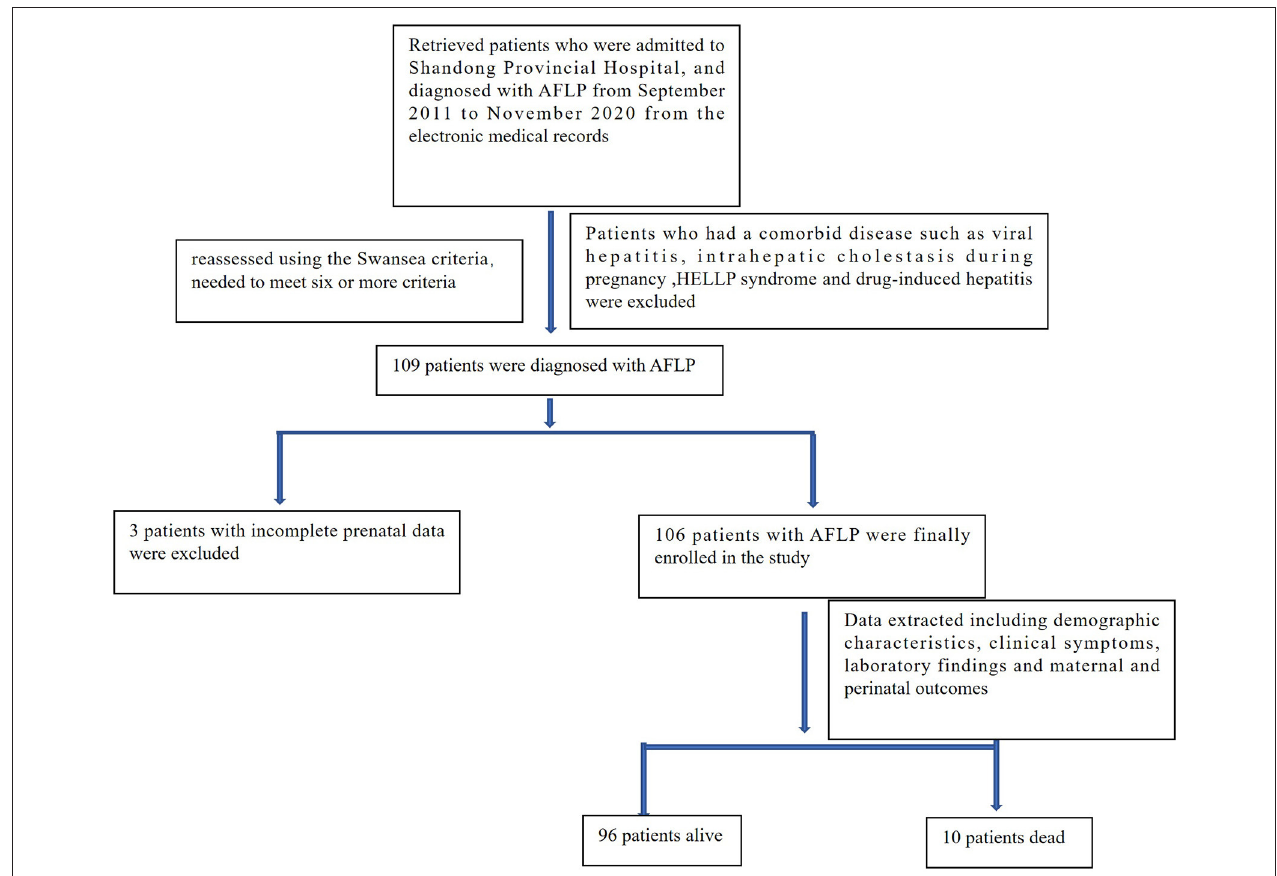
FIGURE 1 | Flow chart of patient